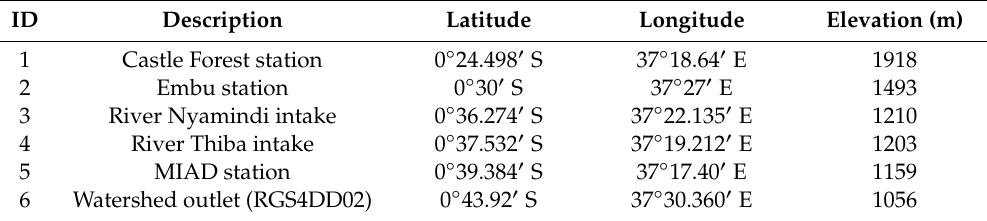
Table 5. Observed weather stations, intakes and watershed outlet information.